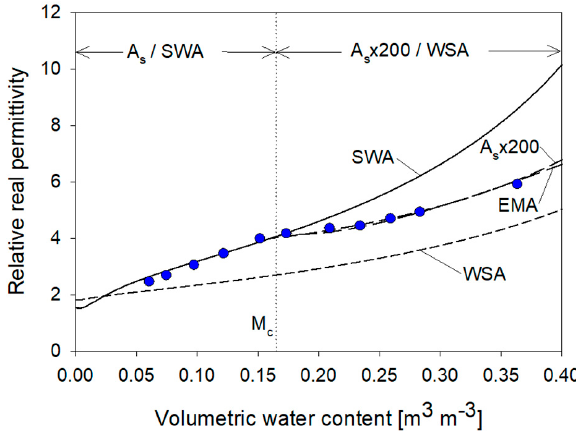
Figure 13. Measured permittivity of field corn at 200 MHz (digitized from [12]) modeled using surface area ( A s = 200 m 2 g − 1 ) and using a combination of phase configurations, SWA and WSA as described by Jones and Or [26]. The data were modeled by increasing specific surface area beyond the critical moisture content, Mc, and adding only the incremental water phase permittivity which required A s = 40,000 m 2 g − 1 for fitting. Using a different approach, an effective medium approximation (EMA) was applied where all water below M c was entirely configured as SWA and after M c a phase configuration of WSA was used.